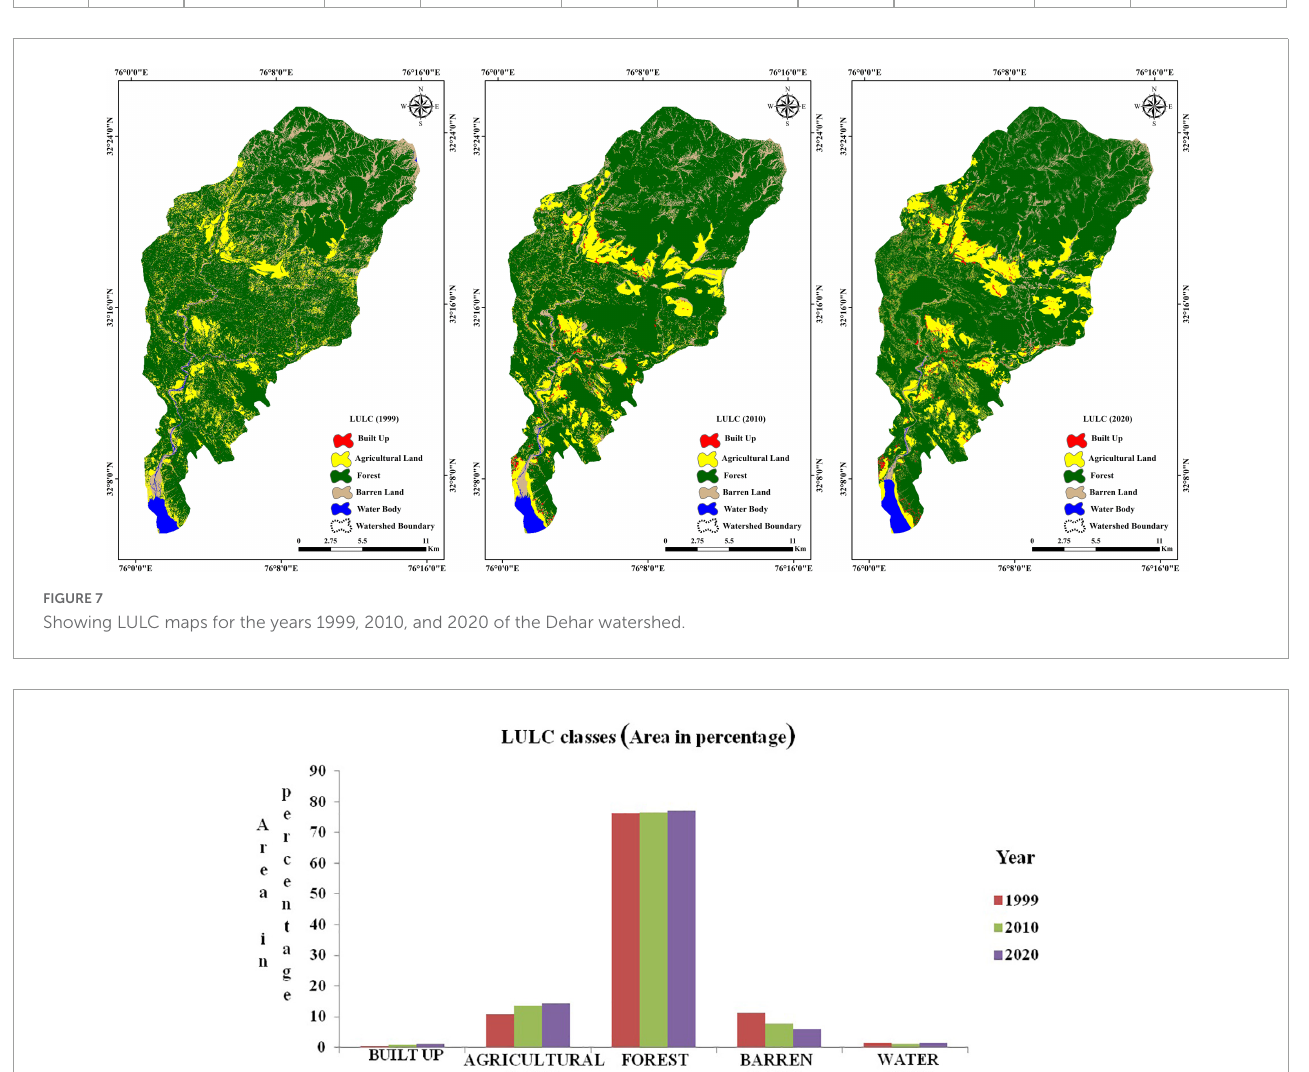
FIGURE8 Bar graph showing the change in different LULC classes for the years 1999, 2010, and 2020 of the Dehar watershed.